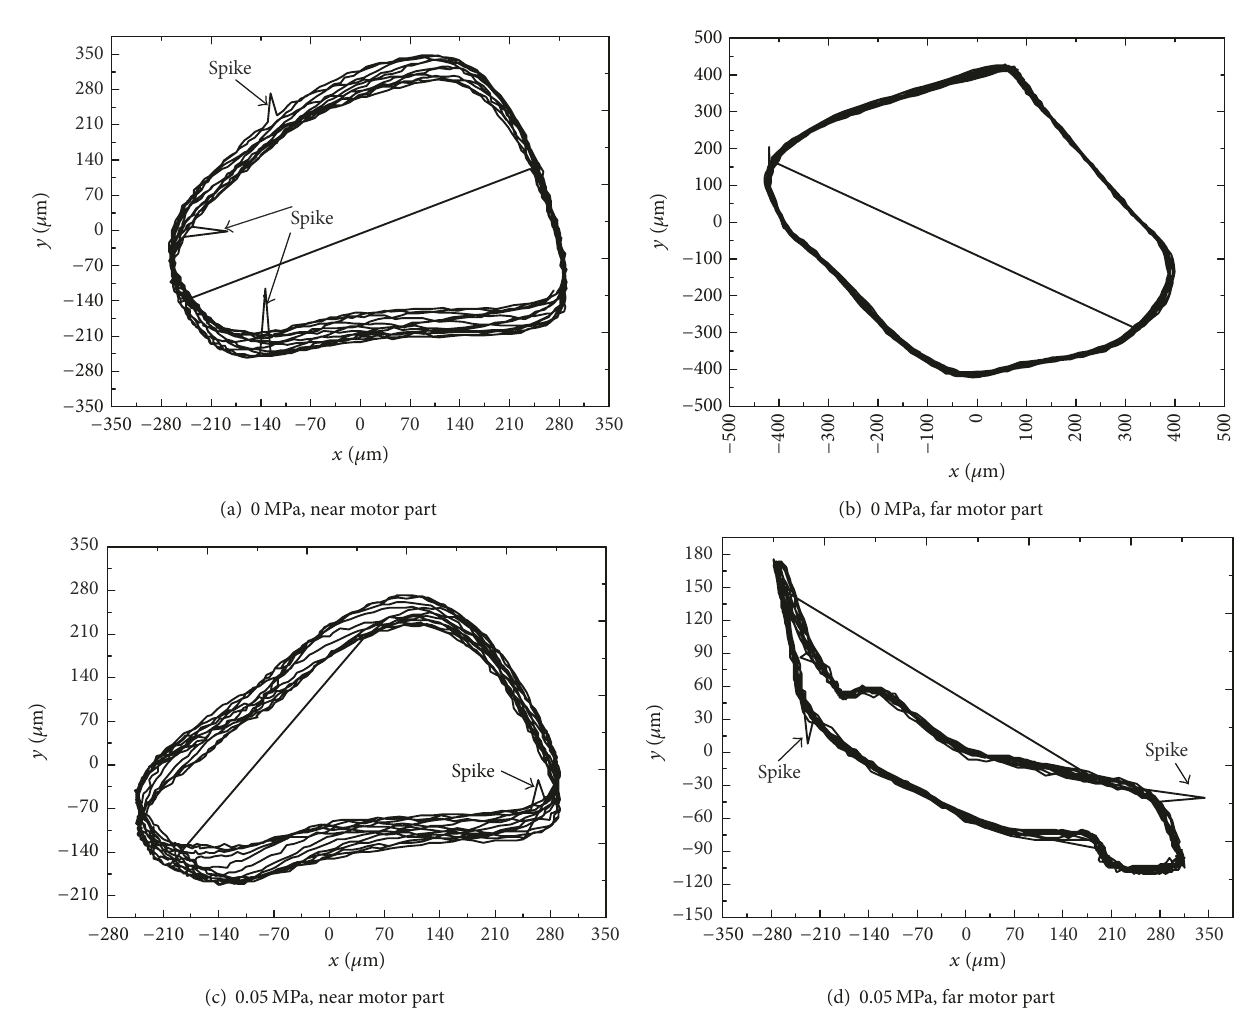
Figure 9: Shaft orbit in 700